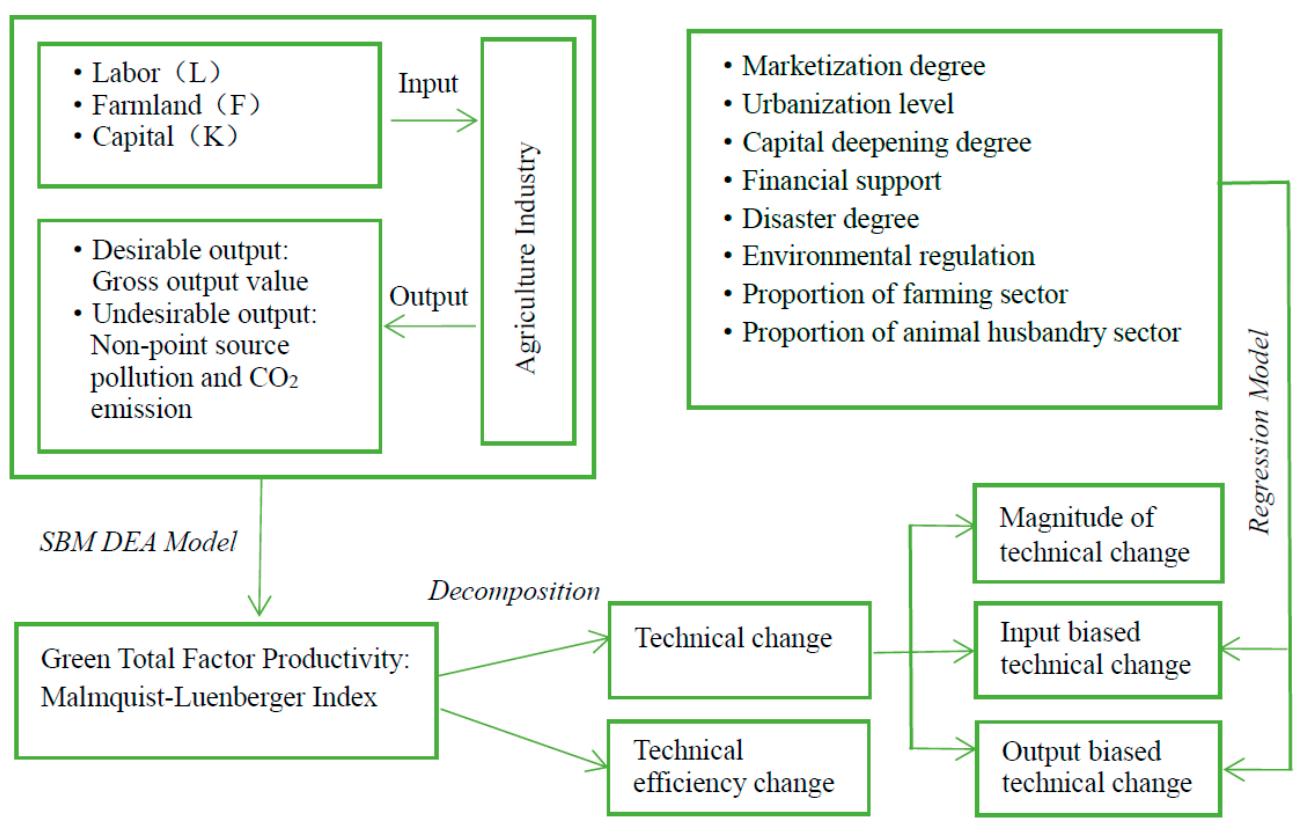
Figure 1. Analytical framework.